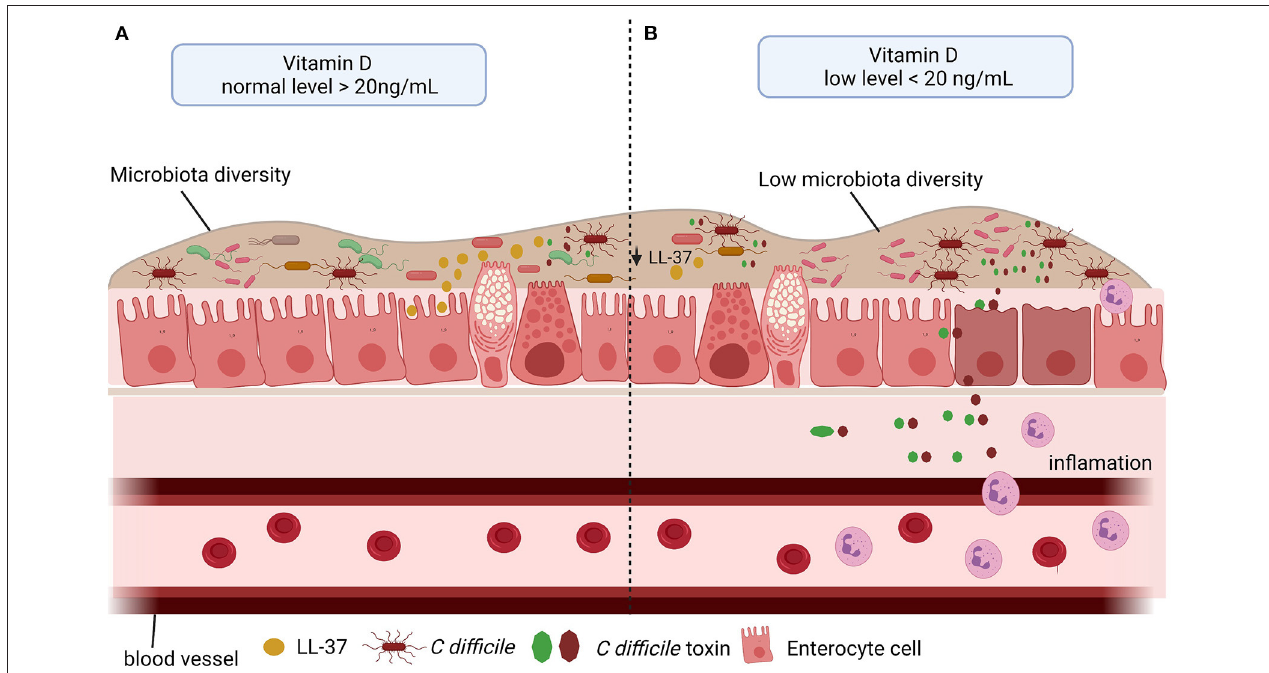
FIGURE 4 | Vitamin D level and C. difficile infection (CDI). (A) The vitamin D stimulates the microbiota diversity and the cathelicidin (LL-37) production, which in turn inhibits the effect of C. difficile toxins. (B) Low level of vitamin D impacts negatively microbiota diversity and in LL-37 production, consequently, promotes the C. difficile colonization, toxin production and